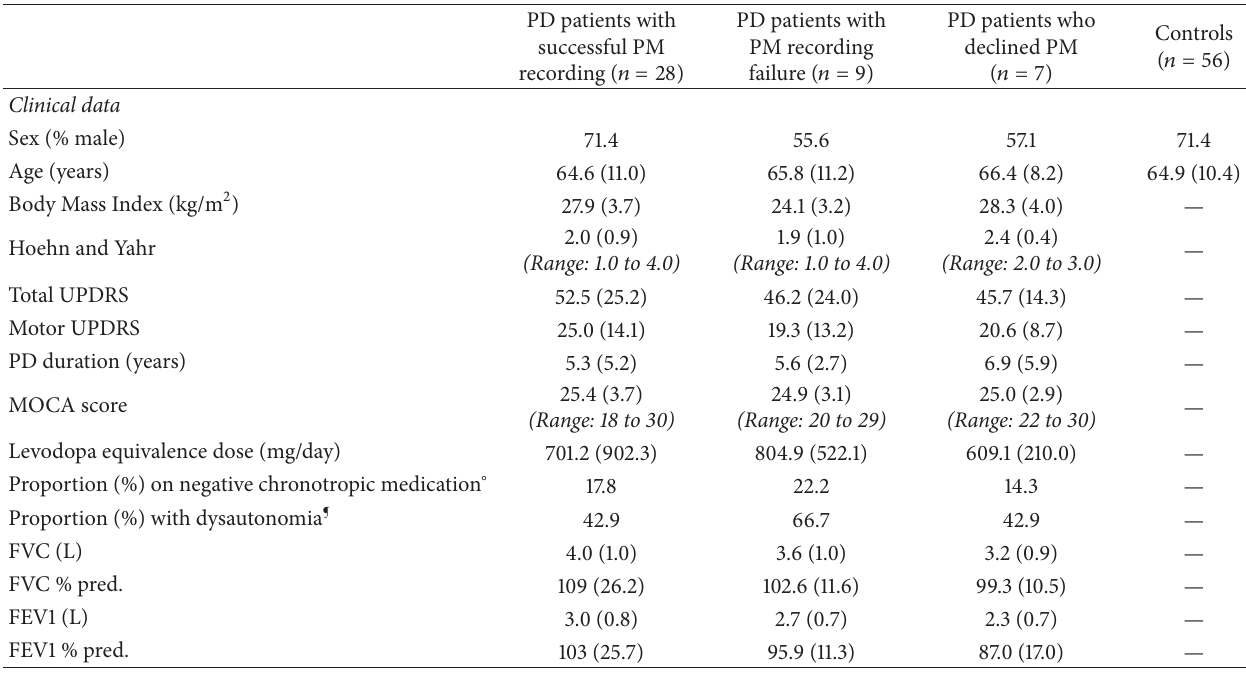
∘ Negative chronotropes include either beta-blockers or calcium channels blockers.